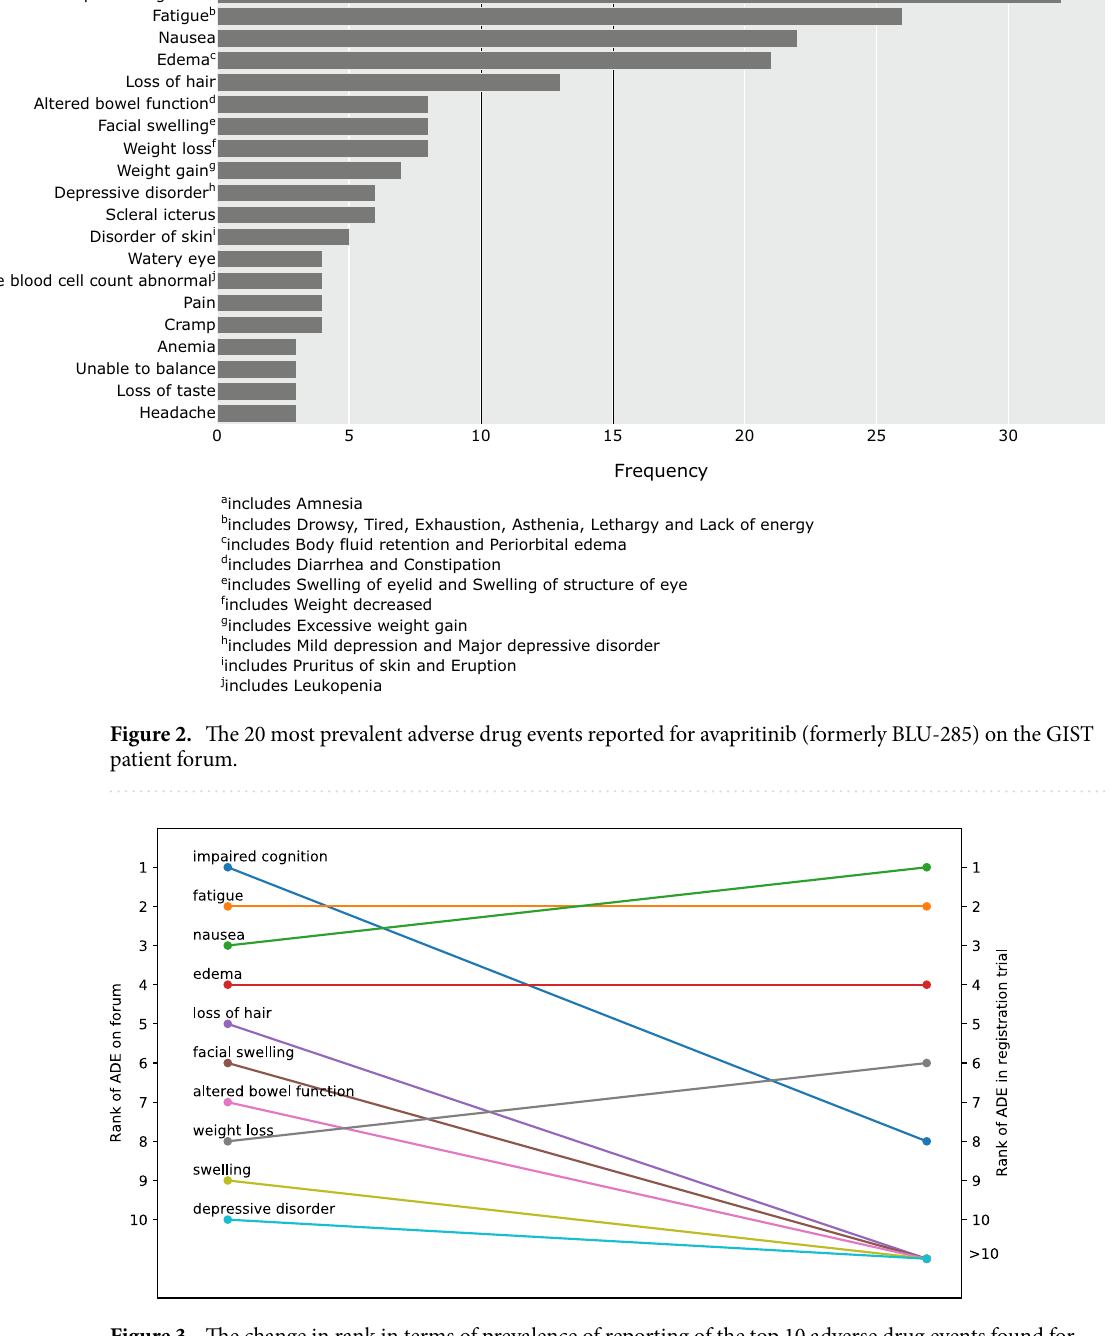
Figure 3. The change in rank in terms of prevalence of reporting of the top 10 adverse drug events found for avapritinib on the forum (left) compared to the registration trial (right). ADE: adverse drug